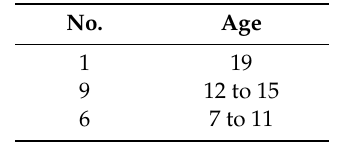
Table 2. Age of participants.